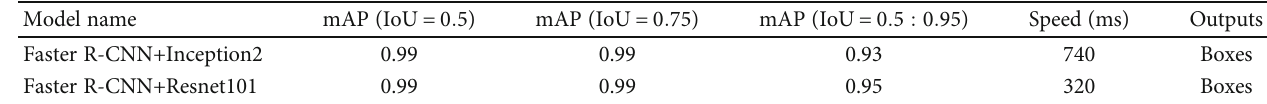
Table 3: Network model